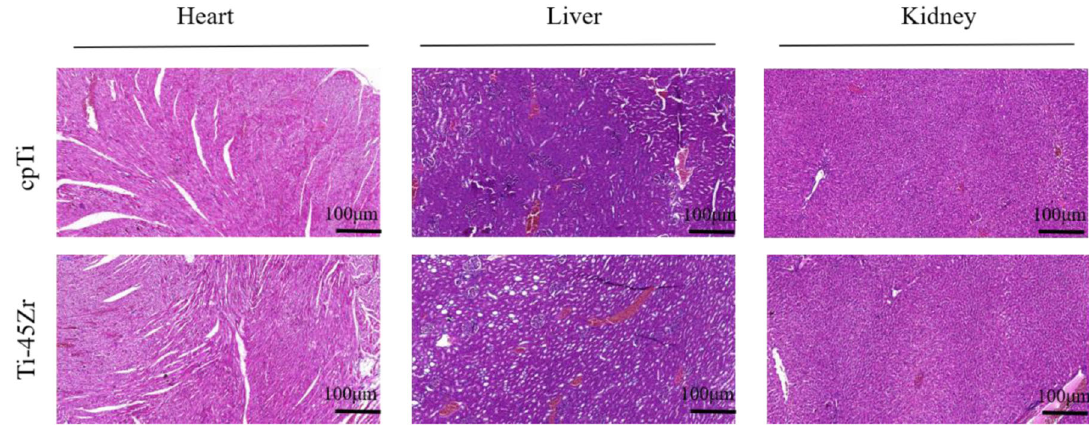
Fig. 11 HE staining of heart, liver, and kidney of rabbits